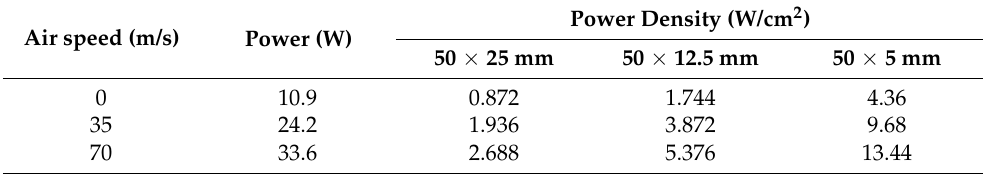
Table 2. Matrix of power consumption at different air speeds and for different heated